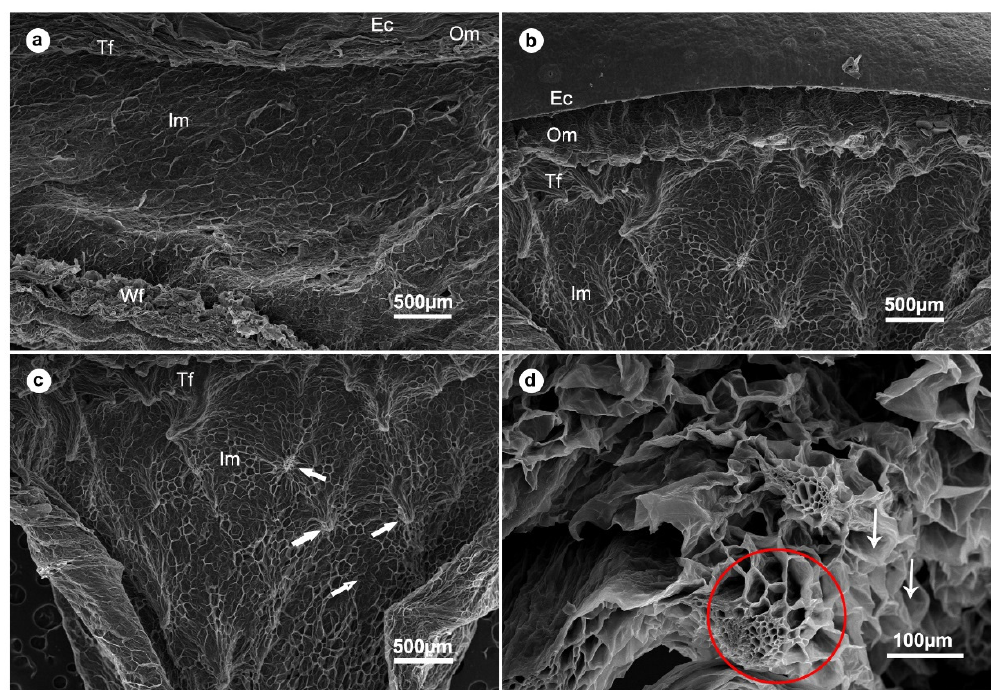
Figure 3. Scanning electron micrographs of date fruit showing effect of spraying with methyl jasmonate and melatonin at 50 ppm on the fruit tissues. Where ( a ) untreated fruit (control) showing the exocarp (Ec), which is comprised of layers of the cuticle, epidermis, hypodermis, and sclereid cells, the outer mesocarp (Om), tanniferous layer (Tf), inner mesocarp (Im), and white fiber bundles (Wf), ( b ) treated fruit showing Ec, Om, Tf, Im layers, ( c ) a micrograph focusing on the inner mesocarp (Im) of the treated fruit showing the fibrovascular bundles (thick arrows), and ( d ) an enlarged micrograph of treated date fruit showing vascular bundles (red circle) with xylem vessels and sieve tubes. The thin arrows show the lumen of each cell.